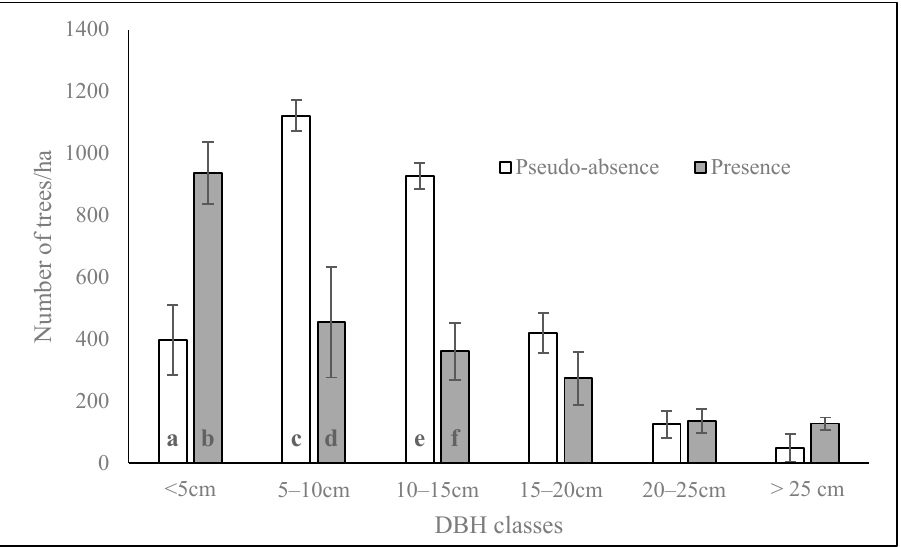
Figure 2. Mean density (±SE) of overstorey trees in the different DBH classes in the CG pseudo- absence and presence locations (alphabetic items show a significant difference between two groups.).